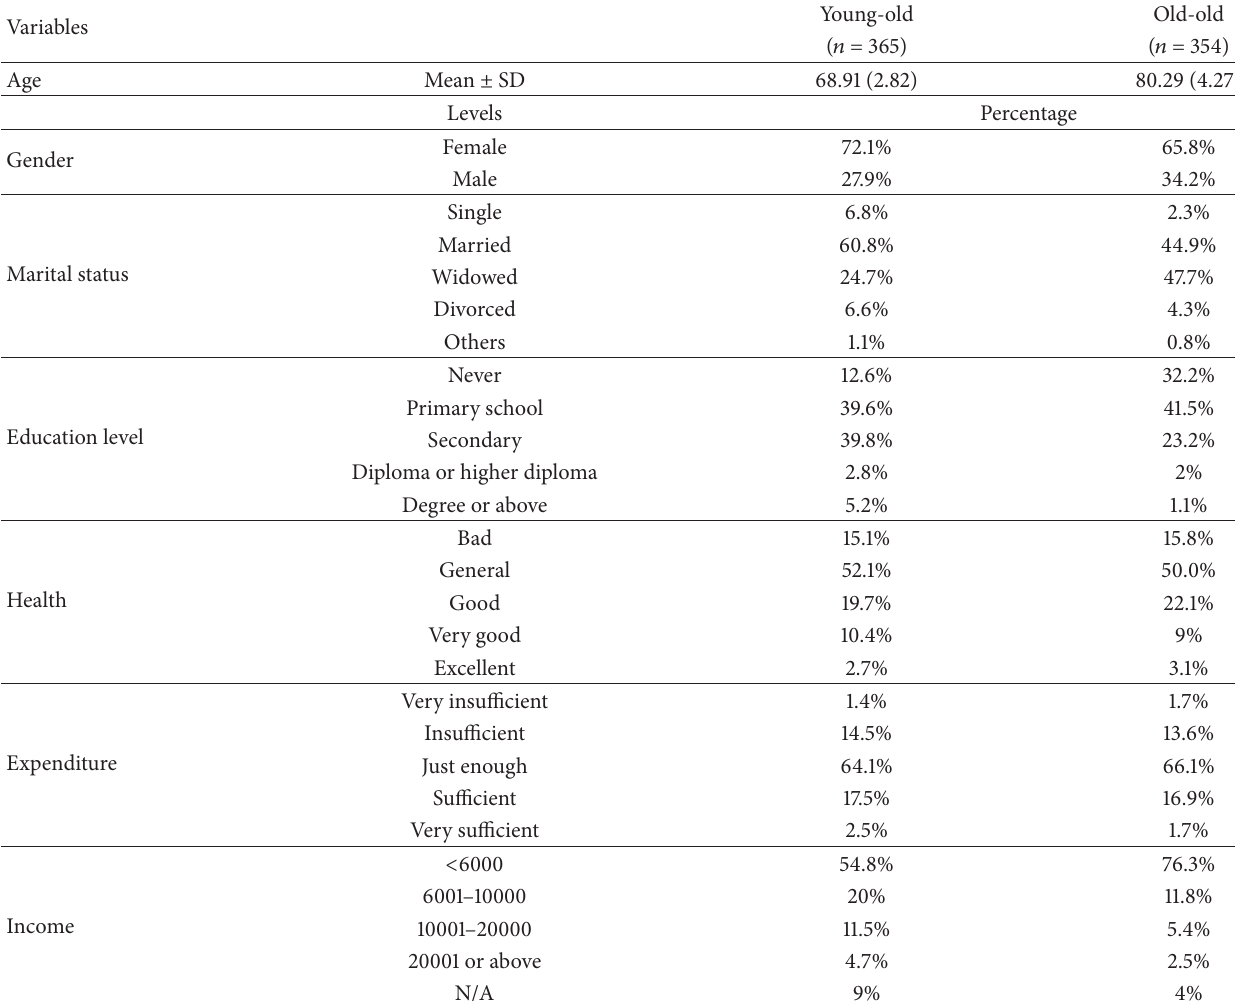
Table 1: Descriptive statistics of sociodemographic variables (mean and SD in age) by age